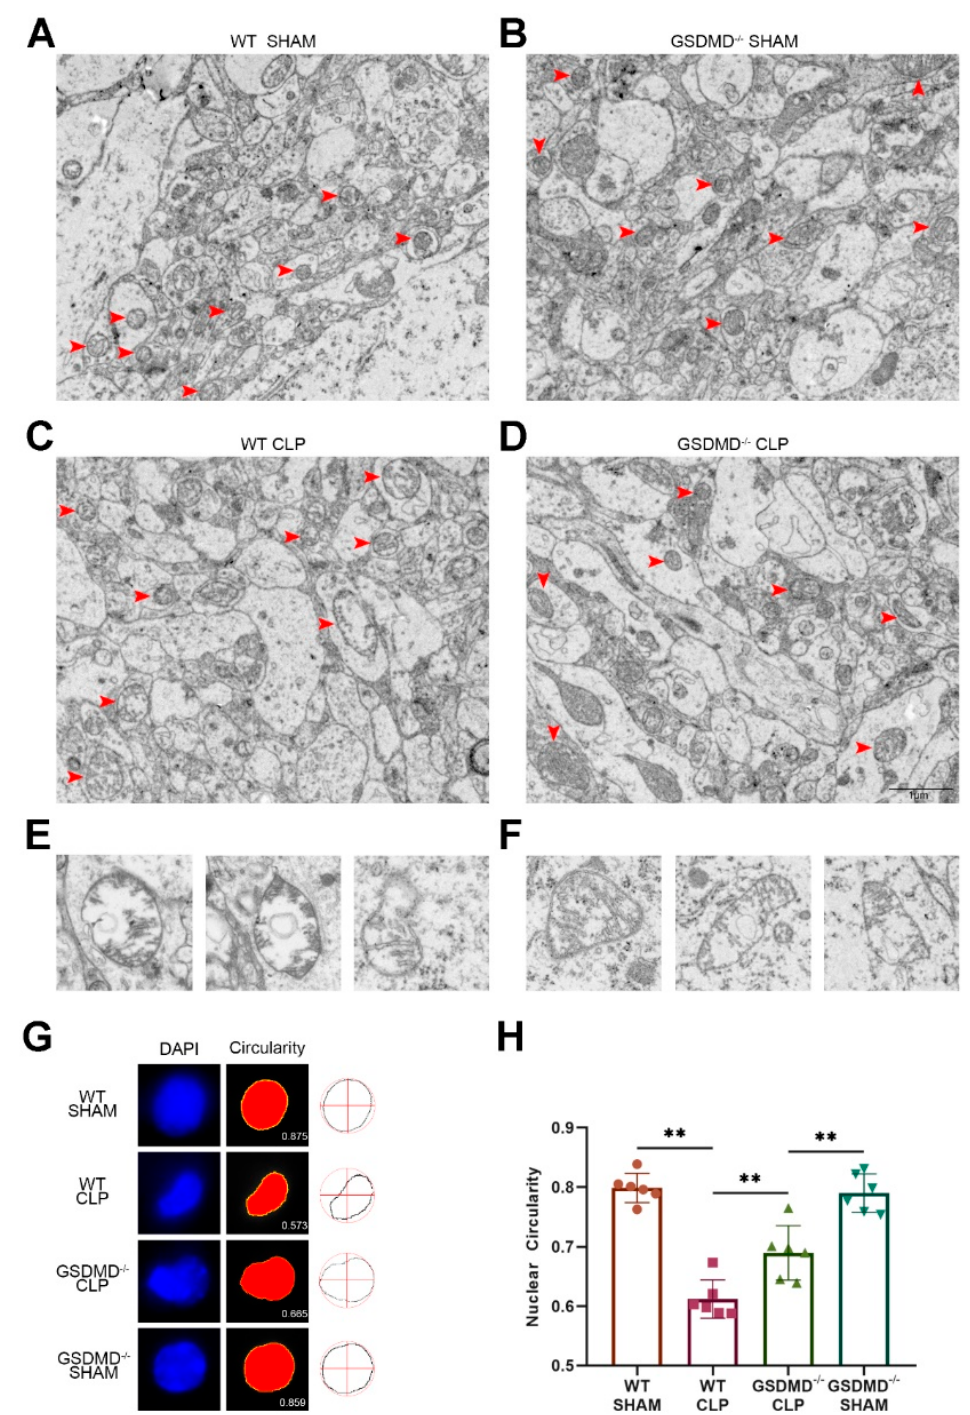
Figure 3. The absence of GSDMD alleviates abnormal morphology of mitochondria and nucleus in the brain of septic mice. ( A − D ) TEM images of mitochondrial ultrastructure in the prefrontal cortex on the 3rd day after surgery. Red arrows: mitochondria. Scale bar: 1 µ m. ( E , F ) Representative images of mitochondria containing double-membranes or edematous mitochondria in wild-type CLP group and GSDMD − / − CLP group. ( G , H ) Nuclear circularity analysis of wild-type sham group, GSDMD − / − sham group, wild-type CLP group, and GSDMD − / − CLP group (n = 6 per group). ** p <